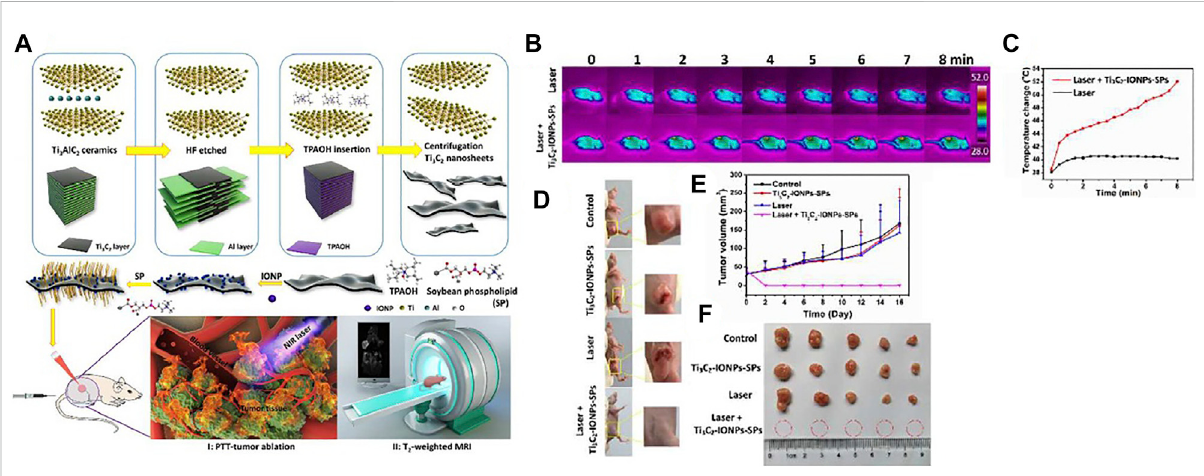
FIGURE 7 (A) Schematic of Ti 3 C 2 -IONPs-SPs synthesis and their multiple functions for tumor theranostics, (B) IR thermographic photographs of cancer mice afore and behind infusion of Ti 3 C 2 -IONPs-SPs nanocomposite followed by NIR radiance, (C) the temperature rise of tumors within the NIR radiance fl ow, (D) Digitalimagesofmicewith4T1tumoronthe16thdaybehindPTTtherapies, (E) Tumorvolume changeplotsofdifferentgroupsof mice carriers of the tumor behind various therapies. (F) Collected digital images of tumors for every group at the PTT therapy end (Liu et al., 2018b).